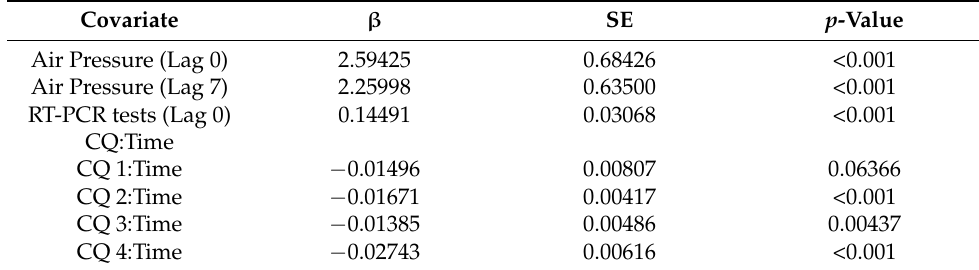
Table 3. Summary results of the final model using stepwise